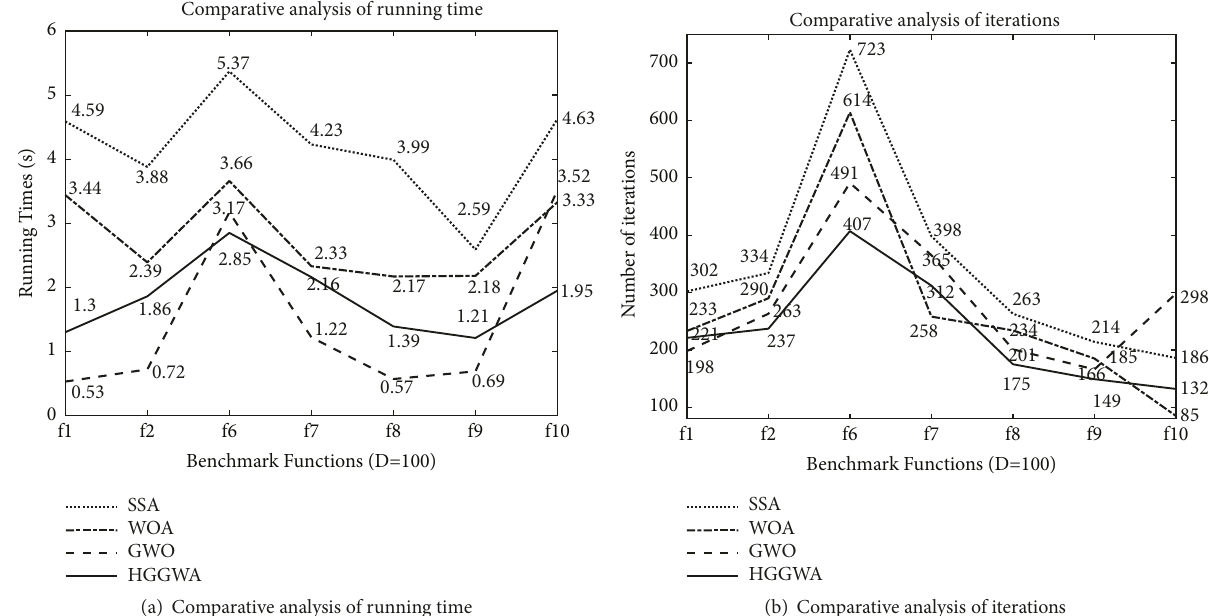
Figure 3: The average running times and iterations of SSA, WOA, GWO, and HGGWA on different test